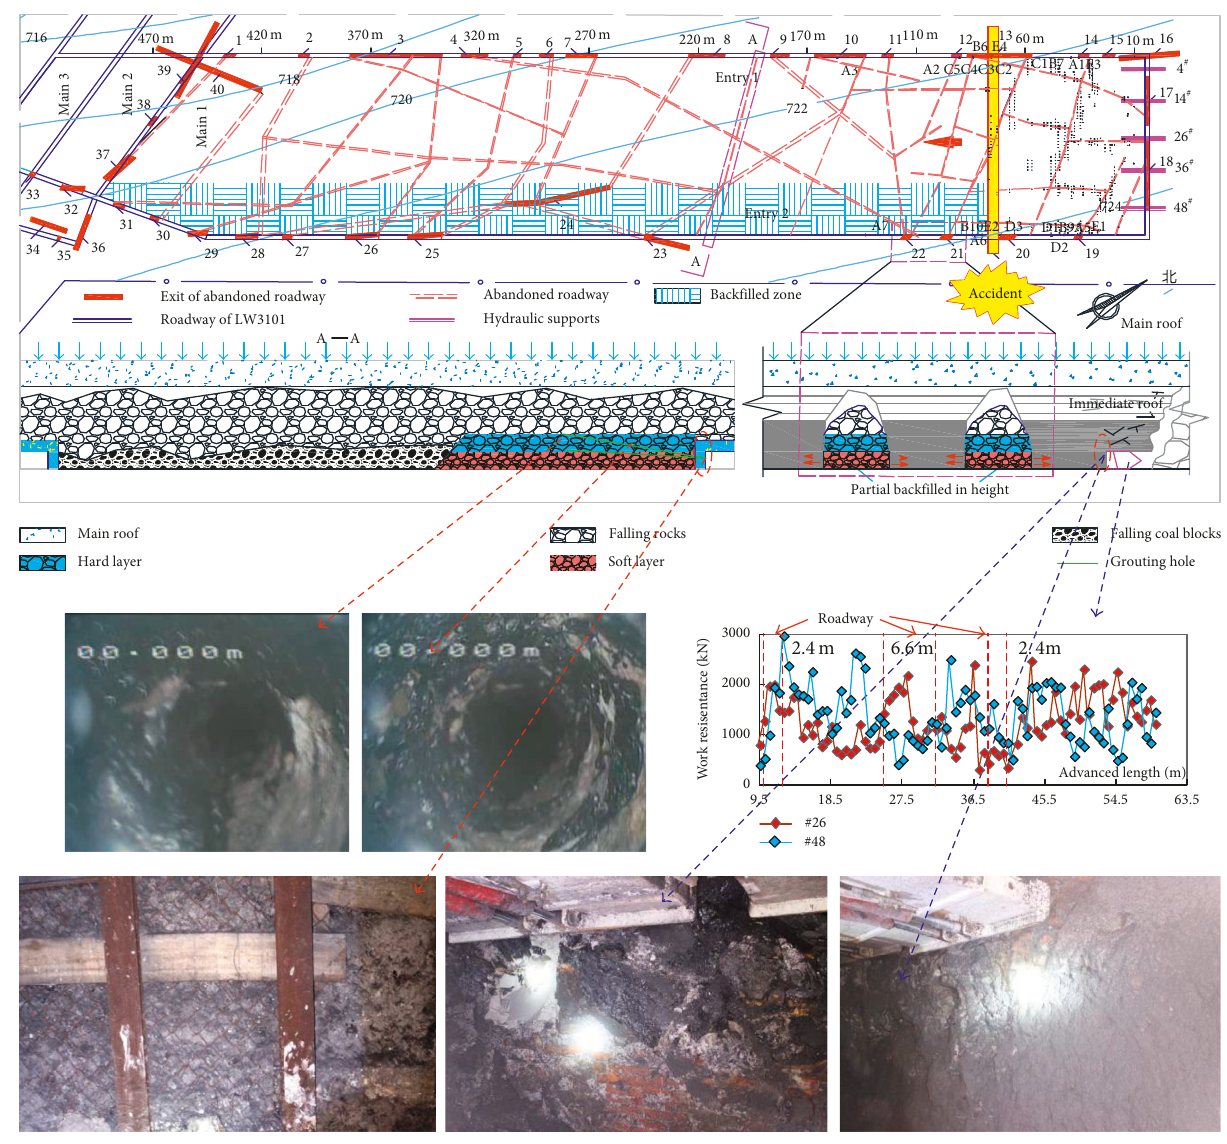
Figure 9: Field backfilled plan and the